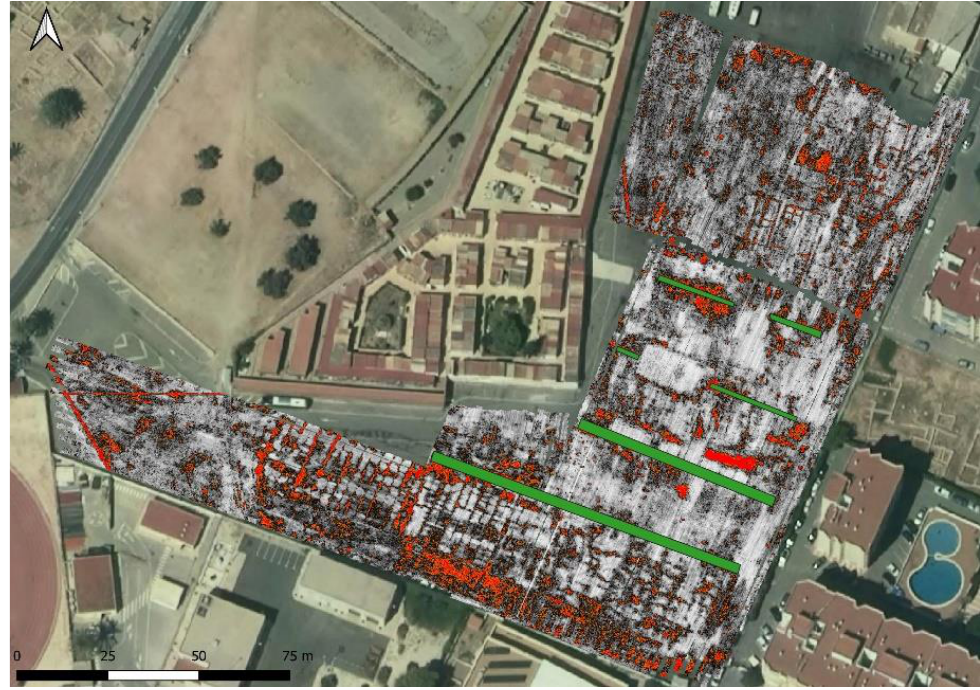
Figure 20. View of the study area showing in green a series of parallel alterations belonging to different sets separated by a regular distance.